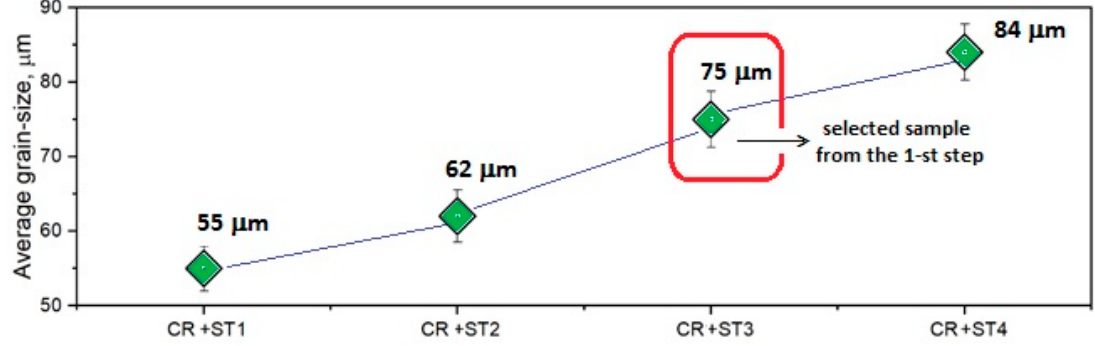
Figure 9. The evolution of the β grain average dimension as a function of the applied TMP variant, corresponding to the 2nd step of the 1st direction of the TMP Program.